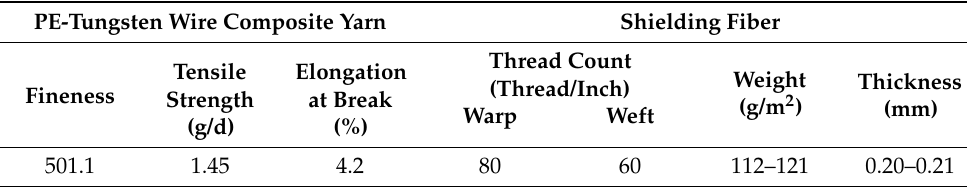
Table 1. Characteristics of medical radiation shielding yarn and fabric.